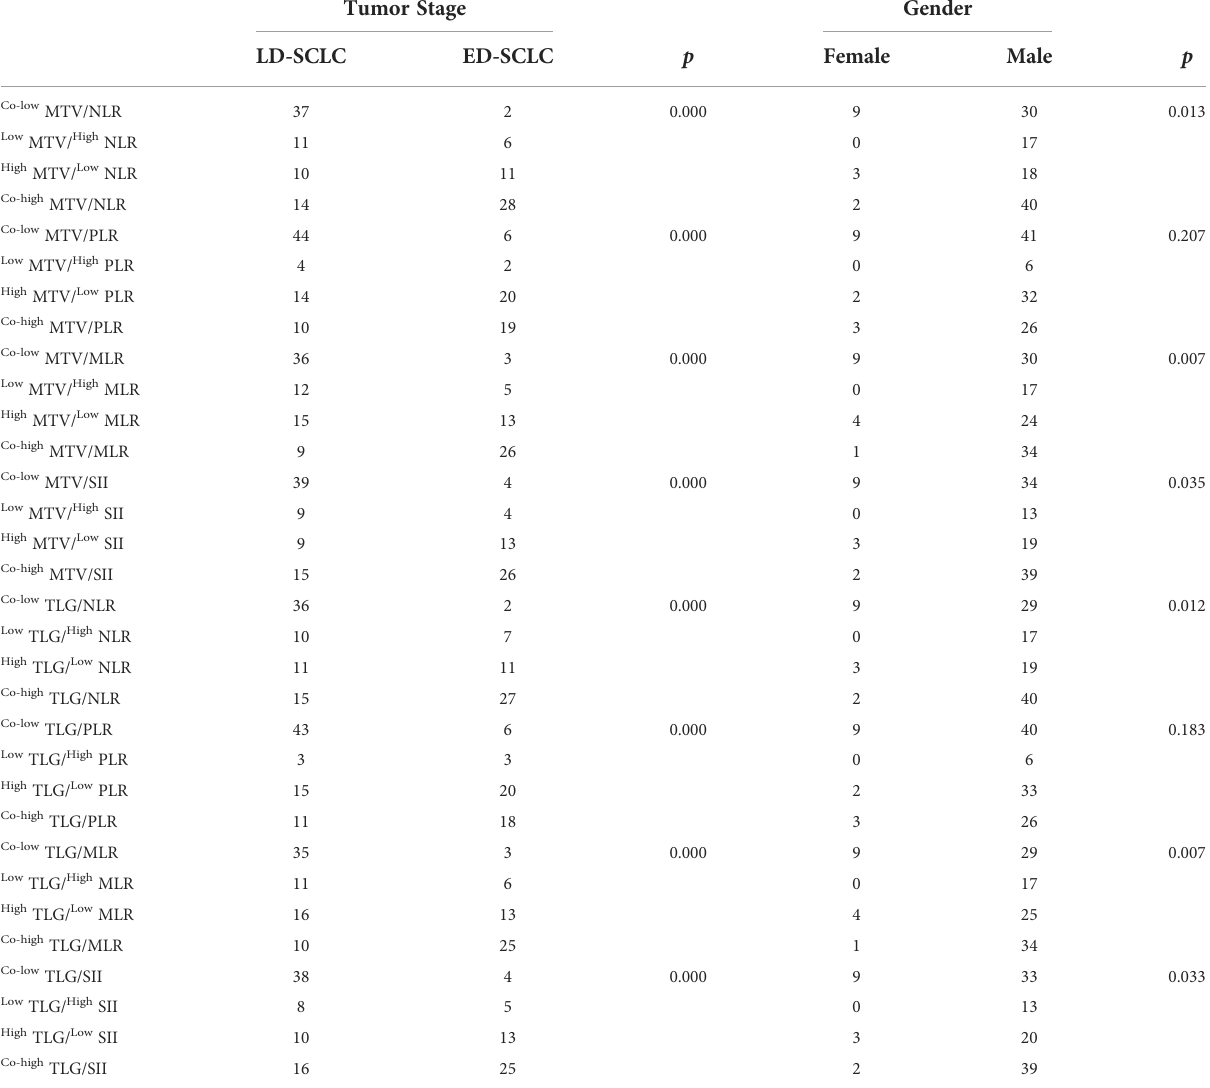
TABLE 5 Relationship of metabolic parameters and in fl ammatory markers with binary stage of